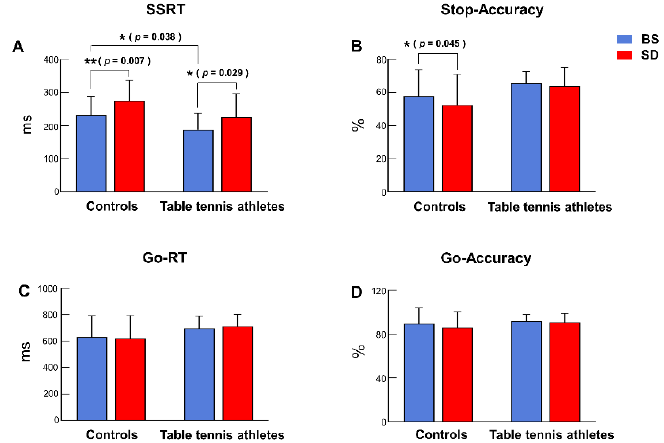
vs. table tennis athletes) × 2 (sleep state: BS vs. SD) two-factor mixed-design ANOVA was